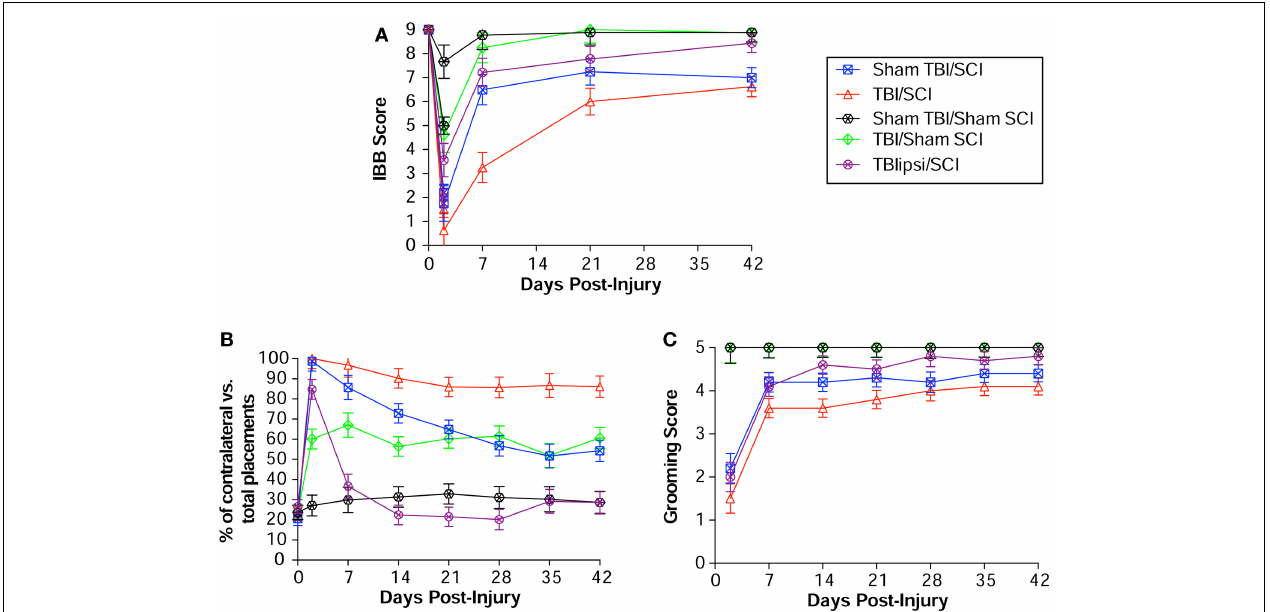
that the IBB was sensitive to the impact of SCI as well as the additive effect of SCI + TBI. (B) Paw placement and (C) grooming in the same subject cohort for comparative purposes. Reprinted with permission from Ref.